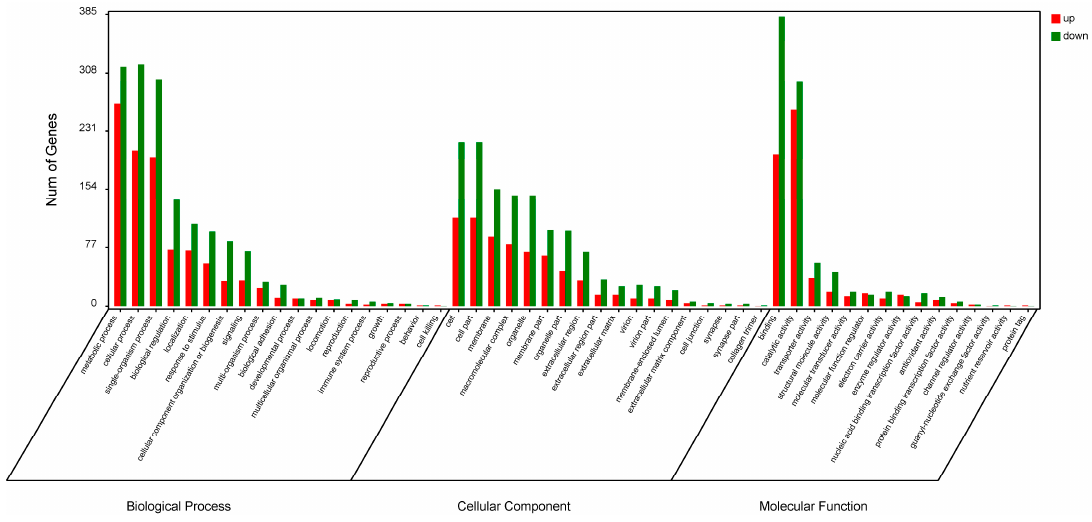
Figure 2. Enriched gene ontology (GO) analysis of differentially expressed proteins after metamorphosis. The most enriched GO terms (based on gene number) in “Cellular component,” “Molecular function,” and “Biological process” are shown.